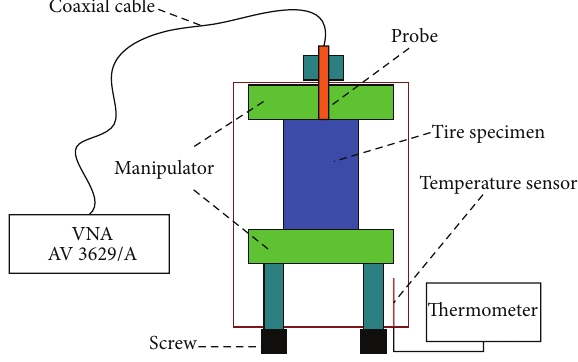
Figure 4: The OCP measurement system.